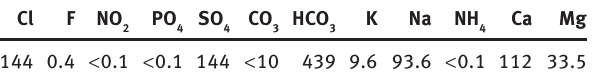
Table 2 Chemical content of tap water (mg/l).